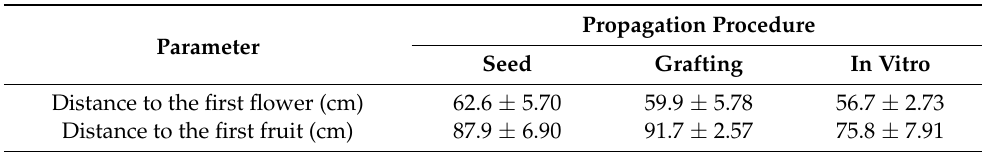
Table 2. Distance from the ground to the first flower and to the first fruit (average ± s.e.) in ‘Alicia’ papaya propagated by seed, grafting, and in